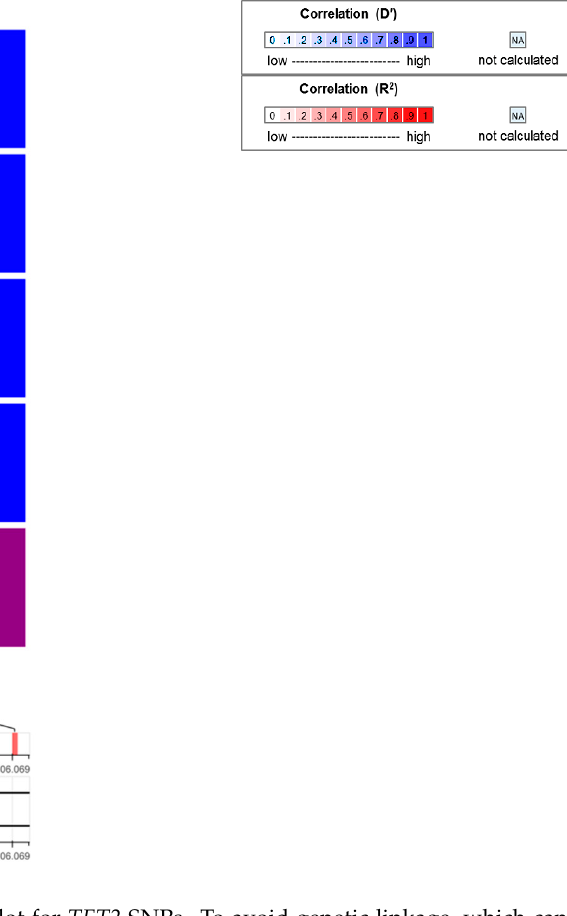
Figure 2. Linkage-disequilibrium plot for TET2 SNPs. To avoid genetic linkage, which can lead to issues in multiple comparisons, a heatmap was created using an interactive online tool (https://Idlink.nci.nih.gove/?tab=Idmatrix, accessed on 20 September 2020) to understand the patterns of linkage disequilibrium between SNPs.